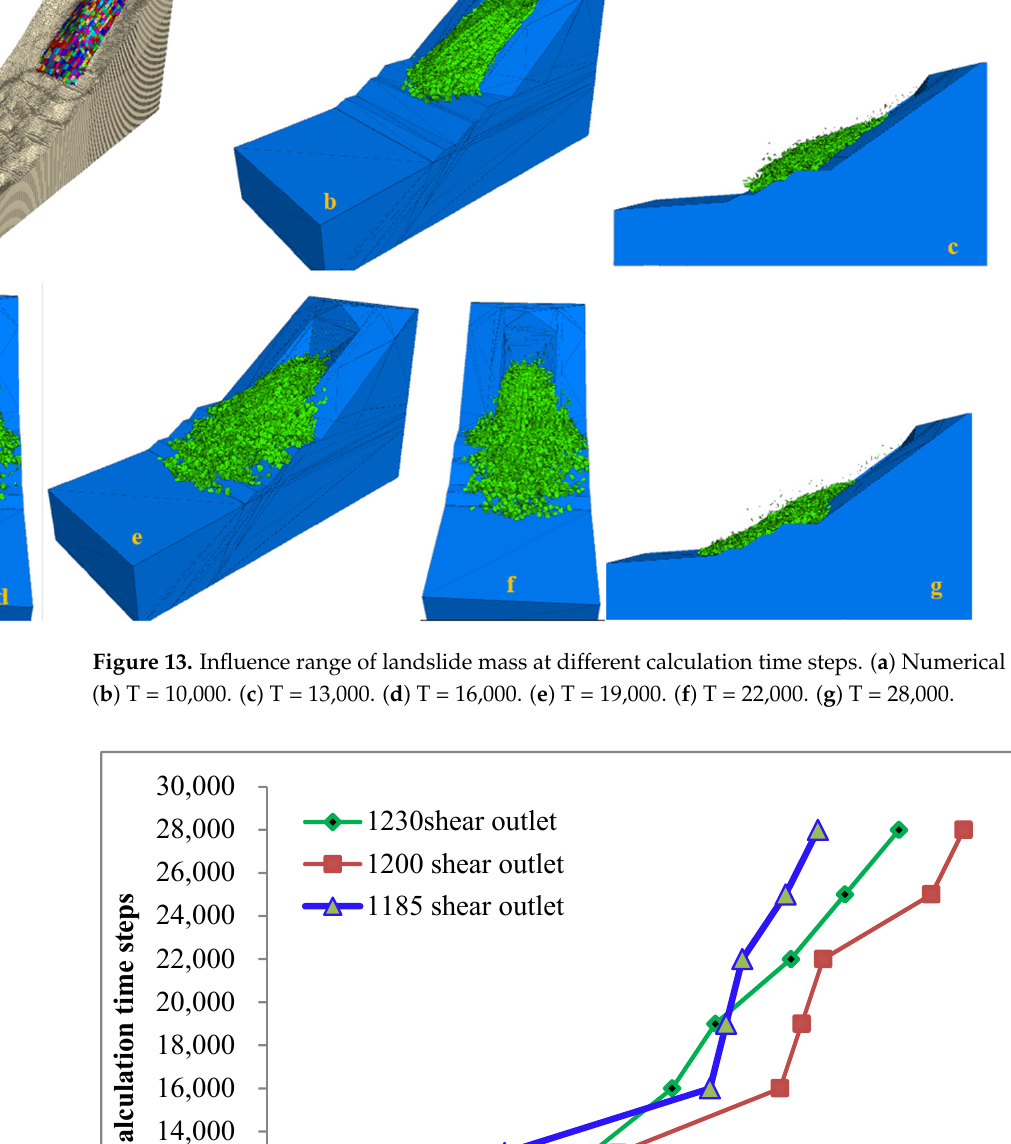
Remote Sens. 2022 , 14 , x FOR PEER REVIEW 22 of 29